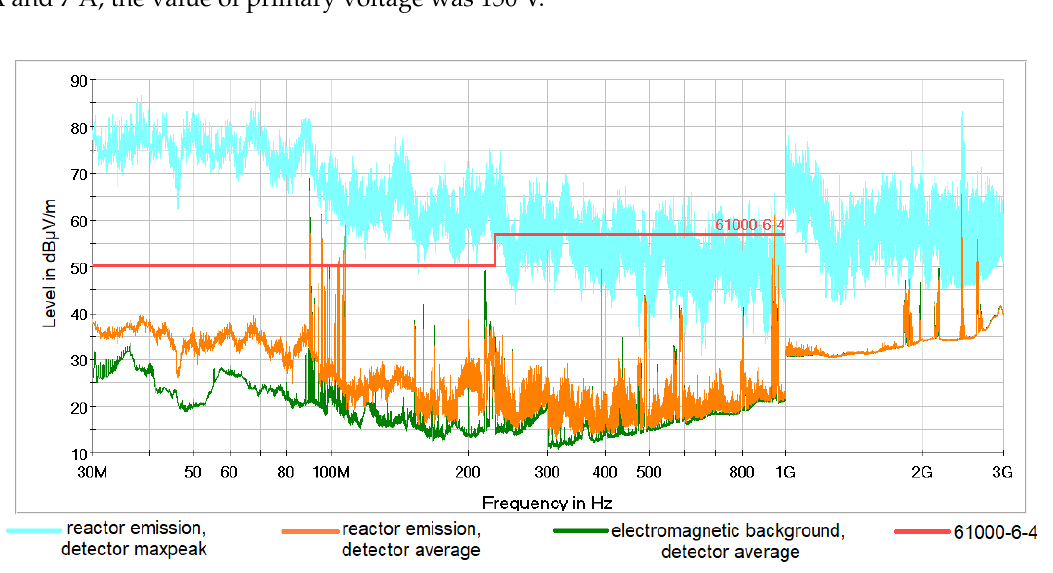
Figure 5. Measurement results — radiated emission, horizontal polarisation.